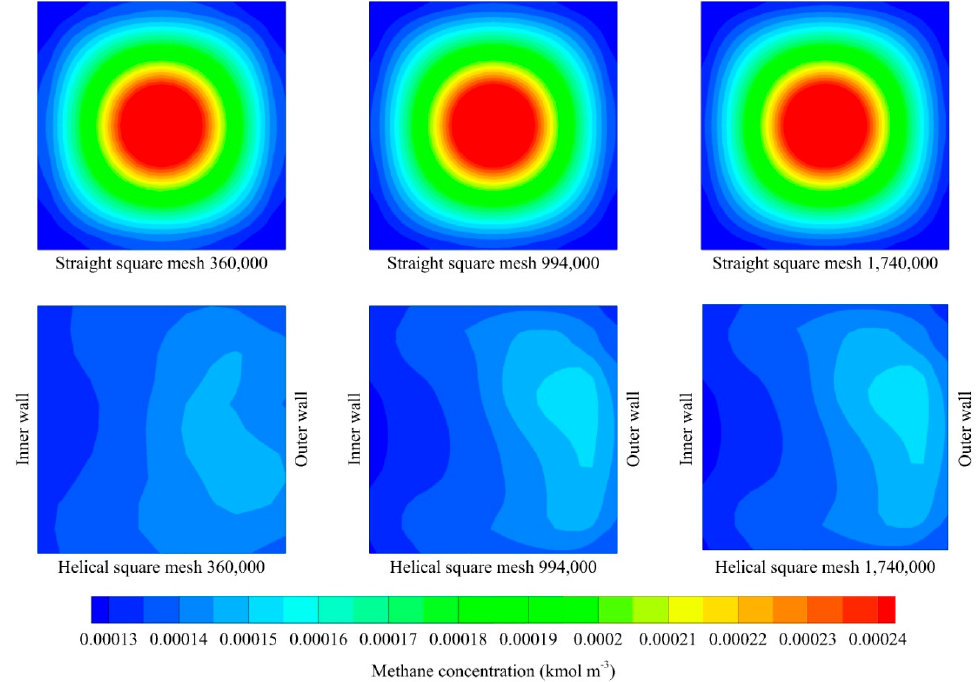
Figure 3. Methane concentration (kmol m − 3 ) of flow in straight and helical squares for various mesh.